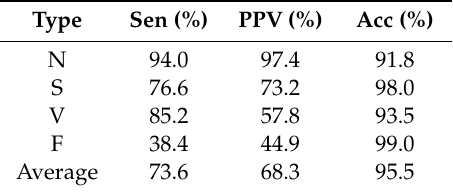
Table 6. The results of the proposed method. Accuracy (Acc), sensitivity (Sen), and positive predictive value